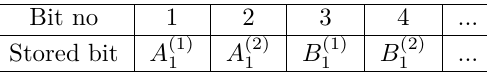
Table 4: Block-wise